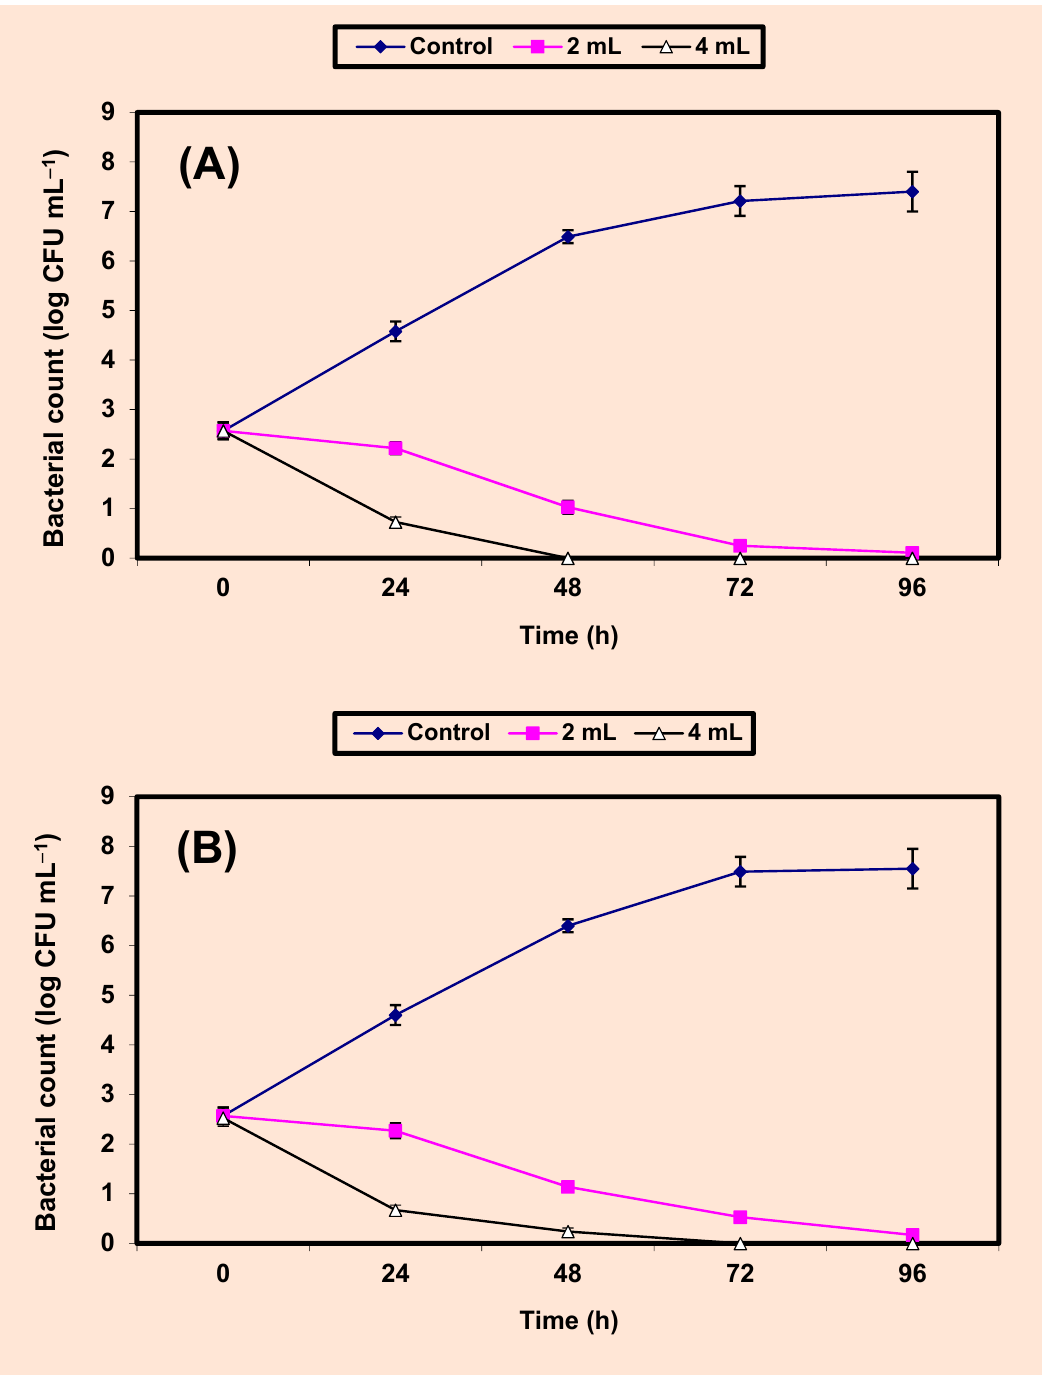
Figure 5. Inhibition of both S. aureus ( A ) and Sal. typhimurium ( B ) in guava juice. Symbols ♦ , ■ , ∆ , refer to control untreated samples, samples treated with 2%, 4% KB, respectively.